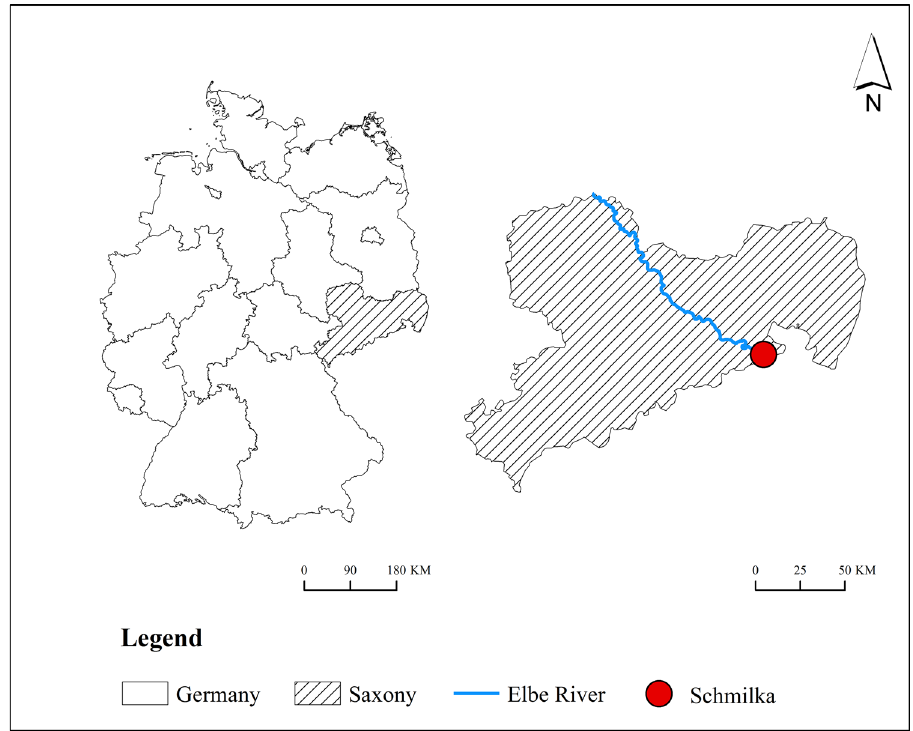
Figure 1. Location of Schmilka station. This figure shows the location of the measuring point. Environmental Systems Research Institute (ESRI). (2018). ArcGIS Release 10.6. Redlands,CA.